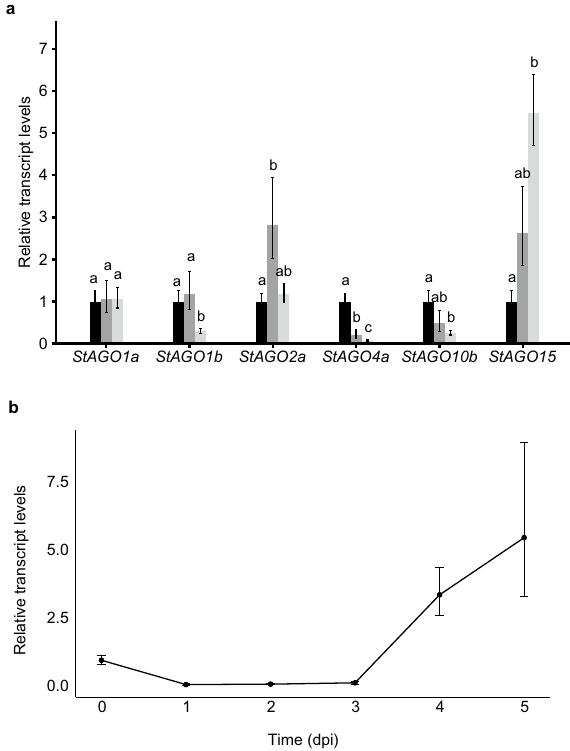
Figure 5. Argonaute expression in potato cv. Desirée during pathogen challenge. ( a ) Relative transcript levels of StAGO genes during pathogen challenge five days post infection (dpi). Black = H 2 O, dark grey = A. solani , light grey = P. infestans NL 11388 strain. Error bars indicate mean ± standard error of the mean (n = 4). Letters in the bar charts (a–c) represent significant differences (one-way ANOVA and Tukey’s HSD test: P < 0.05). ( b ) Relative transcript levels of StAGO15 in a time-course from 0 to 5 dpi when infected by the P. infestans NL 11388 strain. Error bars indicate mean ± standard error of the mean (n =